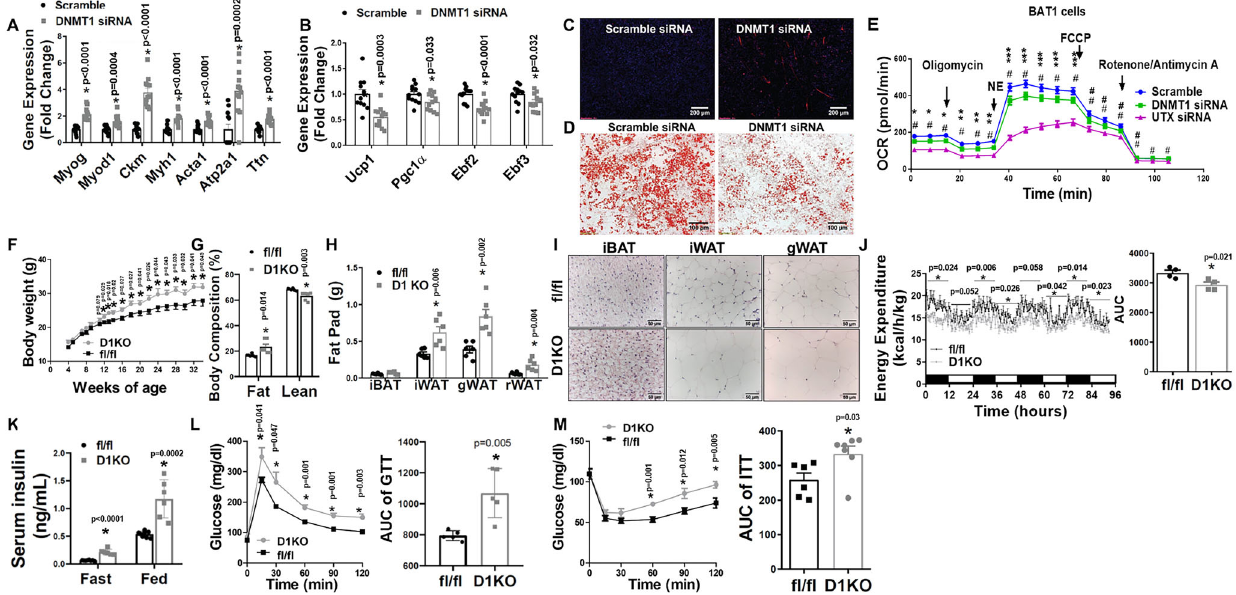
Fig. 5 DNMT1 de fi ciency in brown fat impairs brown fat function. A , B Quantitative RT-PCR analysis of myogenic gene expression ( A , n = 12/group) and BAT-speci fi c gene expression ( B , n = 12/group) in BAT1 brown adipocytes transfected with scramble or Dnmt1 siRNA. *Indicates statistical signi fi cance between Scramble and DNMT1 siRNA groups by two-tailed unpaired Student ’ s t -test. C , D Representative IHC staining of MyHC ( C ) and Oil red O